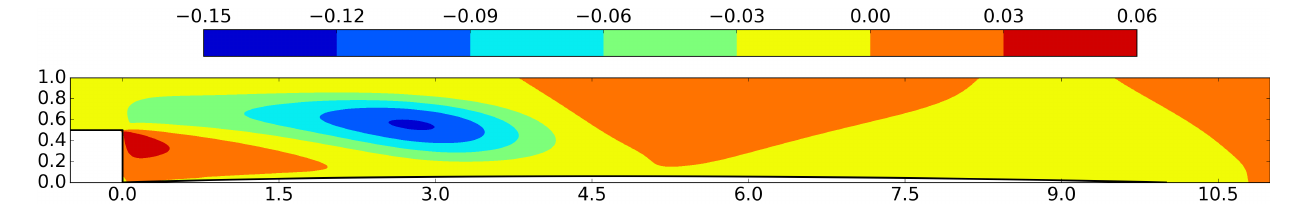
Figure 6. Backward facing step under steady inflow, with control portion l = 10 of elastic membrane bottom wall with T m = 55 and p e = 0.525. Transverse velocity contour plot for − 0.5 ≤ x ≤ 11. The lower wall closed streamlines extend as far as x = 3.55, reducing by 12.7% the uncontrolled separation length of magnitude 4.065 (Section 3.1). The upper wall separation region vanishes. The transverse velocity profile zeroes at x = 17, indicating that the flow is developed at this point. Longitudinal velocity profiles (Figure 5) confirm the observation, as the velocity profile at this point is